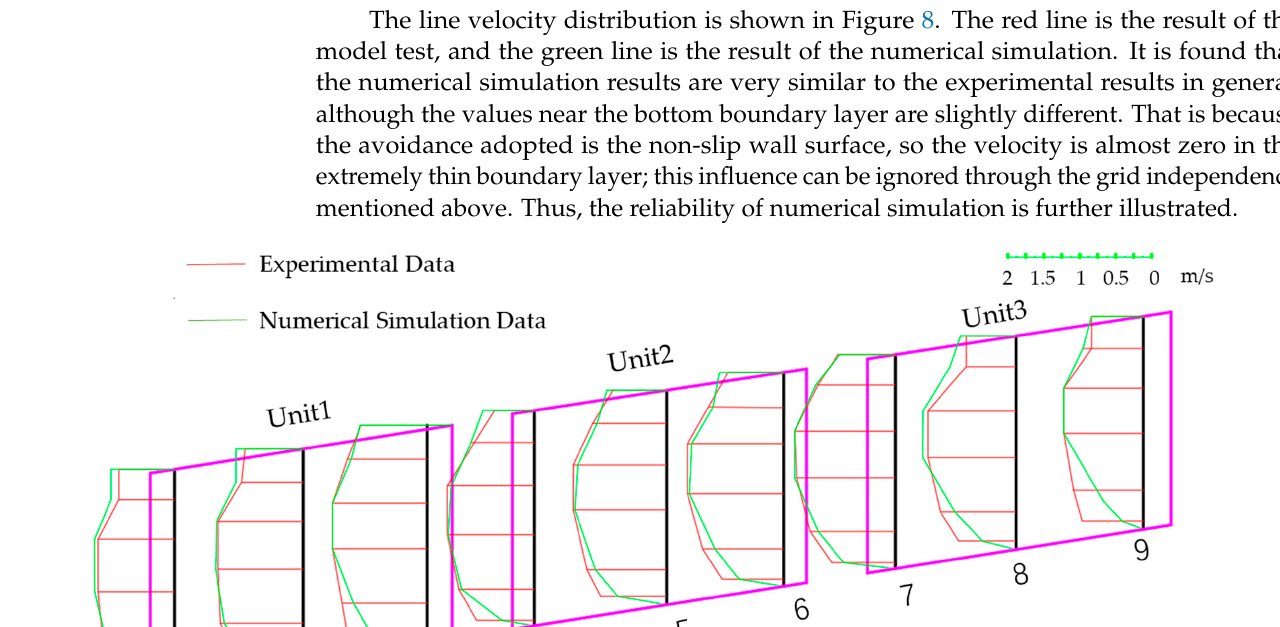
Figure 7. Experimental and simulated bottom laminar flow diagram. ( a ) Test results; ( b ) Numerical simulation results.